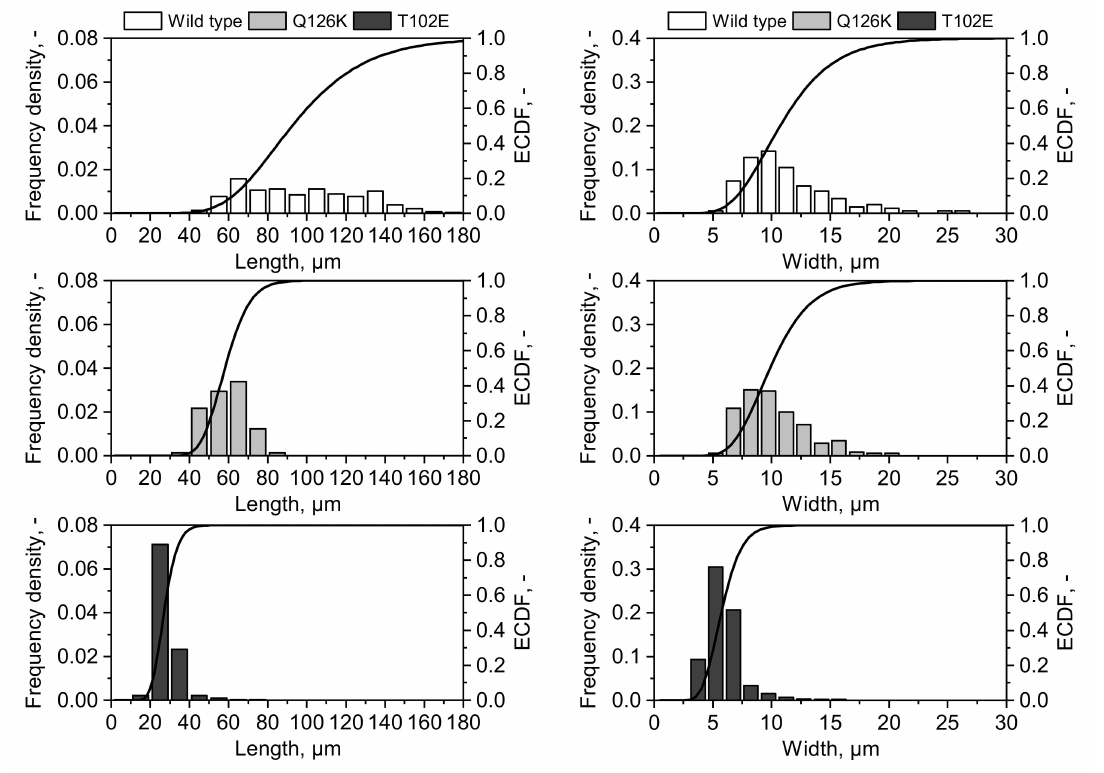
Figure 5. Protein crystal size distribution of Lk ADH wild type and mutants T102E and Q126K (Bar: Frequency density distribution; Line: Empirical cumulative distribution function). The distributions of length ( left ) and width ( right ) of the protein crystals formed after 48 h batch crystallization from clarified and dialyzed E. coli cell lysate in stirred tank reactors (c 0 = 3 g L − 1 , V = 5 mL, n Stirrer = 150 rpm, 20 ◦ C, 100 g L − 1 PEG MME 550). The frequency density distribution of protein crystals in specific length/width classes in µ m was evaluated with OriginPro 2020 (n =